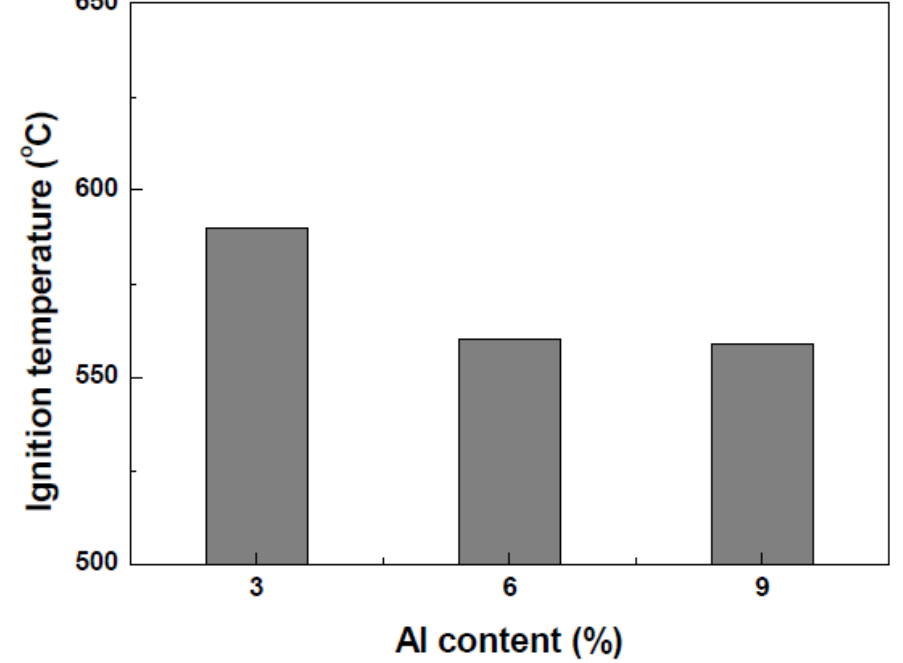
Figure 1. The ignition temperature of Mg alloys decreases as the Mg content increases. Reproduced with permission from [4].